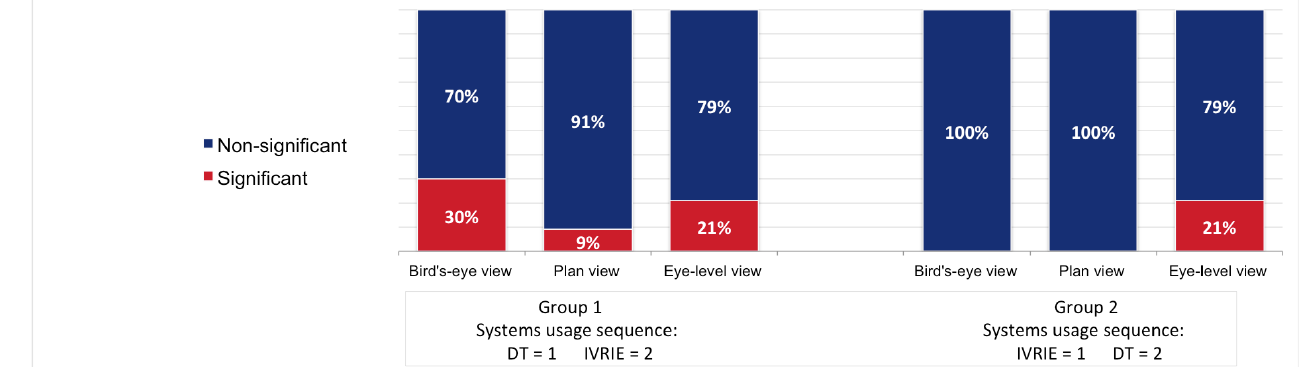
Figure 8. Comparison of both groups of participants’ percentages and significant/insignificant dif- ferences in perceived and actual usage of each kind of